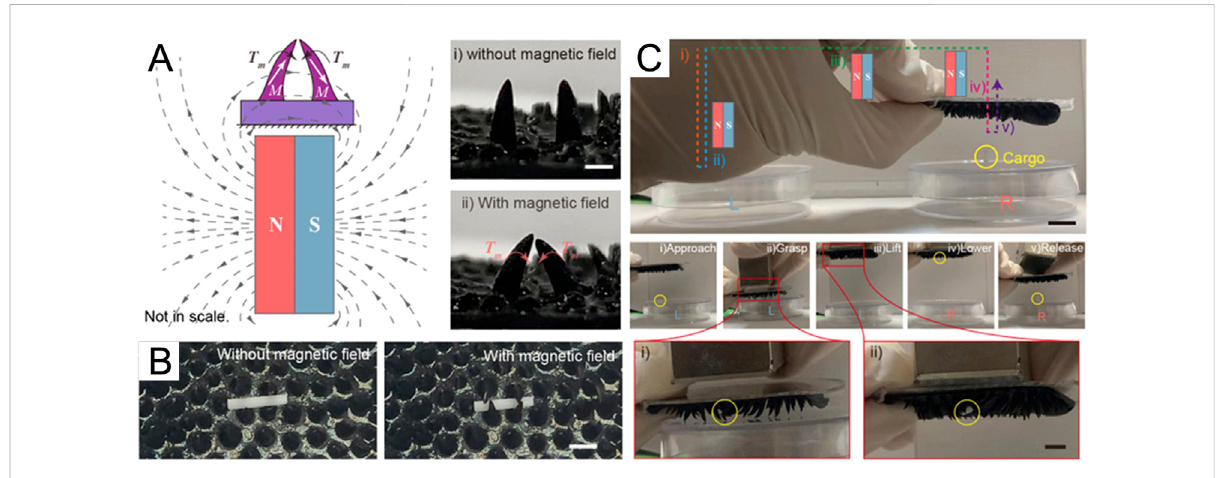
FIGURE 6 Grasping function of the claw-inspired hydrogels. (A) Motions of thelegs with apermanent magnet. Due to the shape of the legs, the magnetic moment could cause the left and right legs to move towards each other, like grasping operation of claws. Scale bar = 1.5 mm. (B) Using magnetic fi elds to control the operation of grasping and releasing Φ 1×5 mm cylinder. Scale bar = 2 mm. (C) Transportability test for grasping cylinder. Scale bar = 10 mm and 5 mm. [Reproduced with permission from (Yang et al., 2022b) Copyright 2022 American Chemical